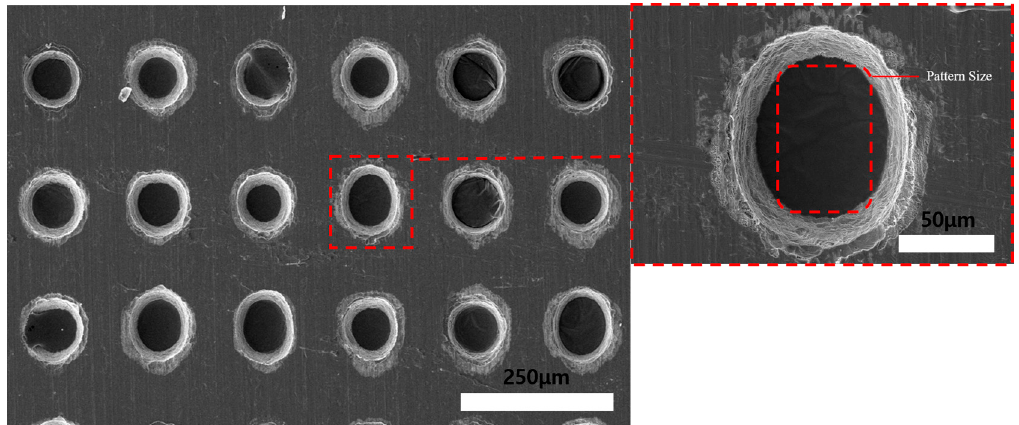
Figure 13. SEM images of Invar thin film after wet etching for 2 min (photoresist coating face etching). Materials 2018 , 11 , 160